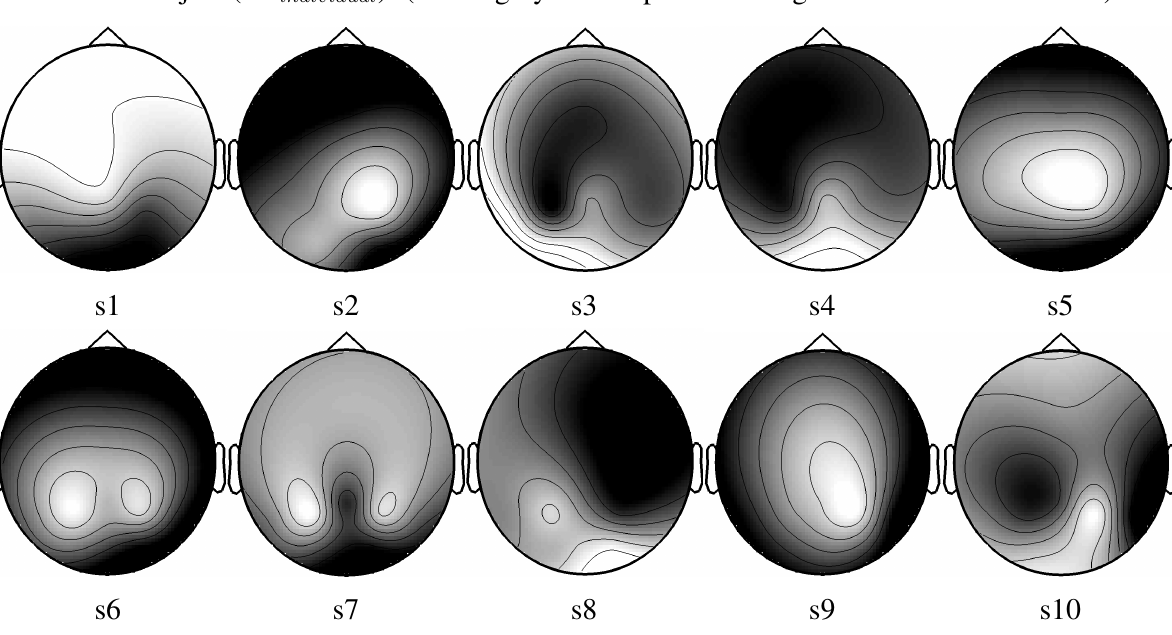
Figure 6. Electrode scores after electrode selection based on the maximization of the SSNR for each subject ( SS ). (A low gray level represents a high score for the individual